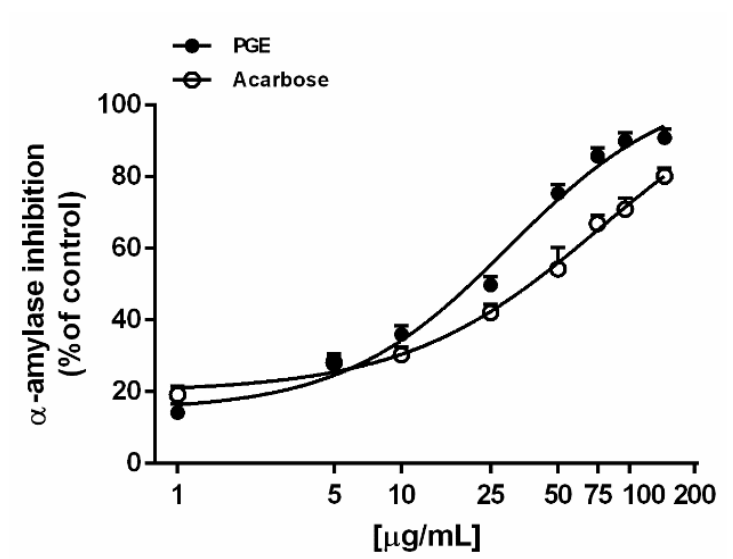
Figure 2. α -Amylase inhibition by the ethyl acetate extract, obtained by Soxhlet from the waste peel of Punica granatum L. var. Dente di Cavallo DC2 (PGE), with respect to the reference standard acarbose. Each value represents mean ± SEM ( n = 4). Table 3. IC 50 values of the ethyl acetate extract, obtained by Soxhlet from the waste peel of Punica granatum L. var. Dente di Cavallo DC2 (PGE), and the positive controls for enzyme inhibition, iron chelating activity, and inhibition of advanced glycation end-products (AGE).